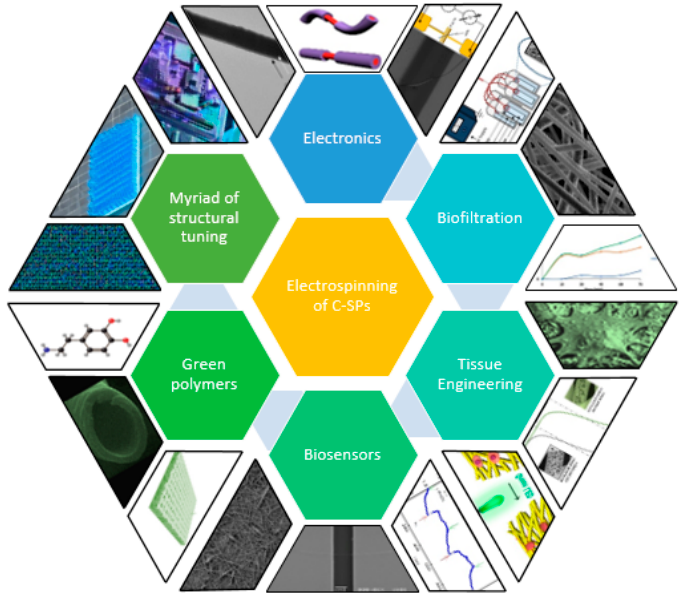
Figure 1. Electrospun nanofibers containing C-SPs: main applications for electronic devices and biological purposes.